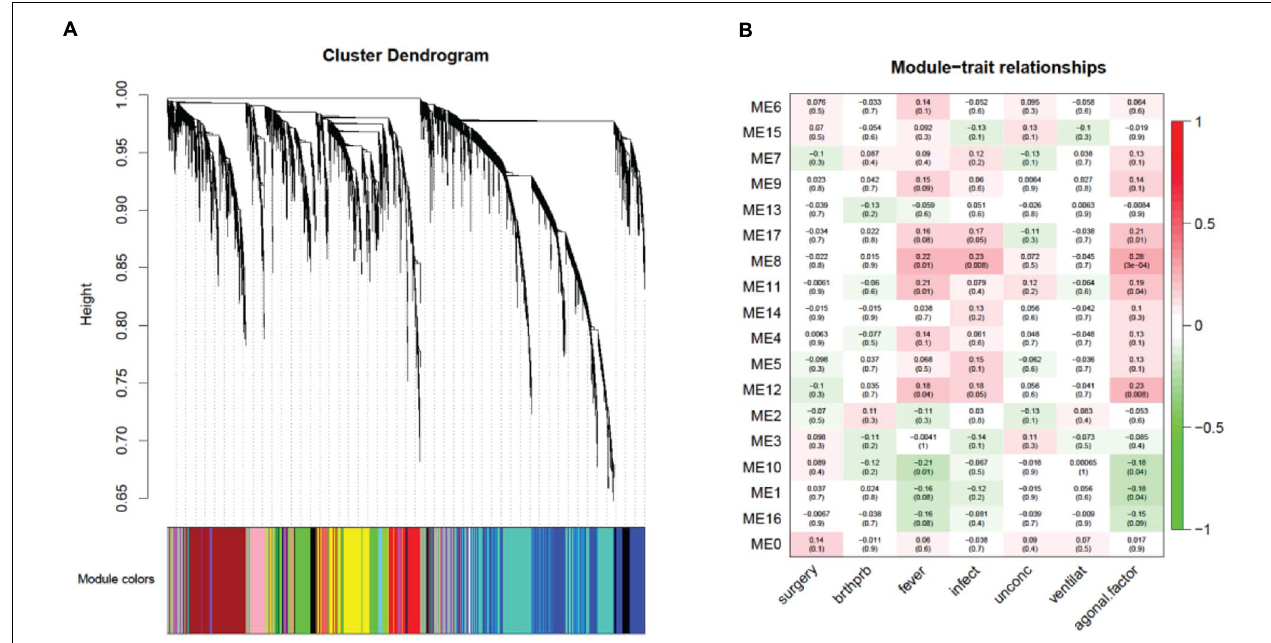
FIGURE 4 | A network dendrogram (A) driven by a weighted gene co-expression analysis (WGCNA) and a module-trait correlation (B) . In total, we identified 18 modules from the ROSMAP dataset. We also identified modules that were significantly correlated with agonal risk factors and the agonal factor score